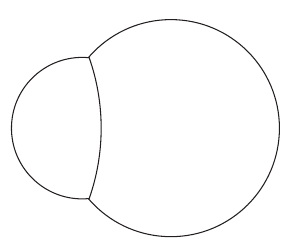
Figure 1.1 . The standard double bubble, consisting of three spherical caps meeting at 120-degree angles, is the conjectured least-area surface that en- closes two given volumes in R n , S n , and H n